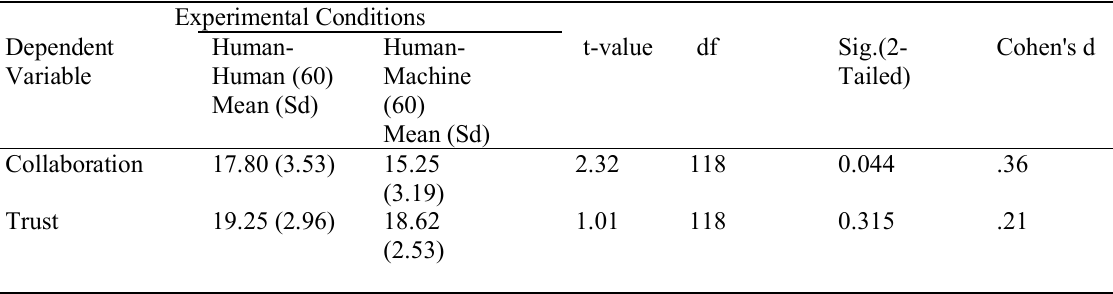
Table 1 . Independent sample t-test analysis of the measures.